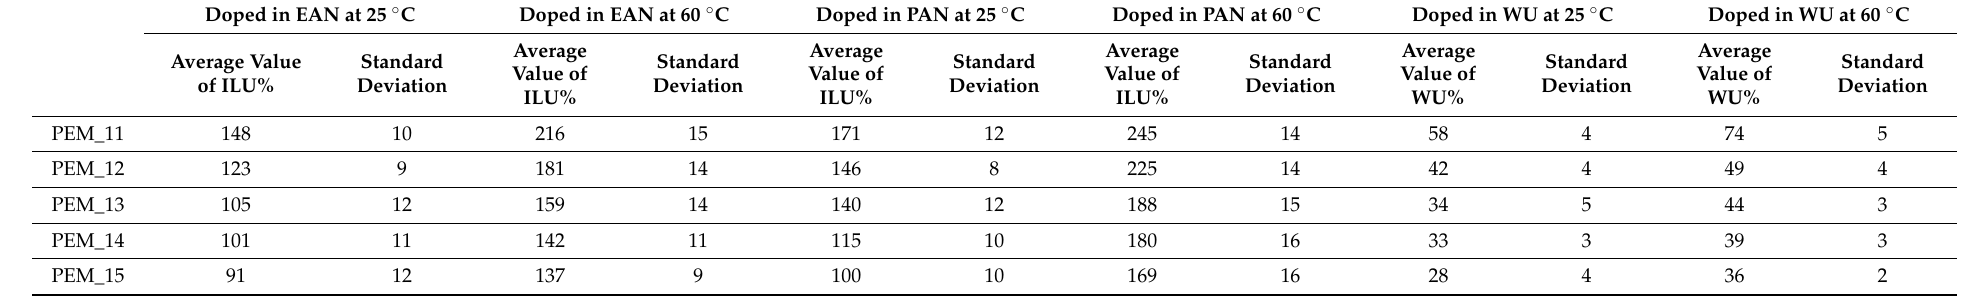
Table 5. Uptake values of PEM_11–PEM_15